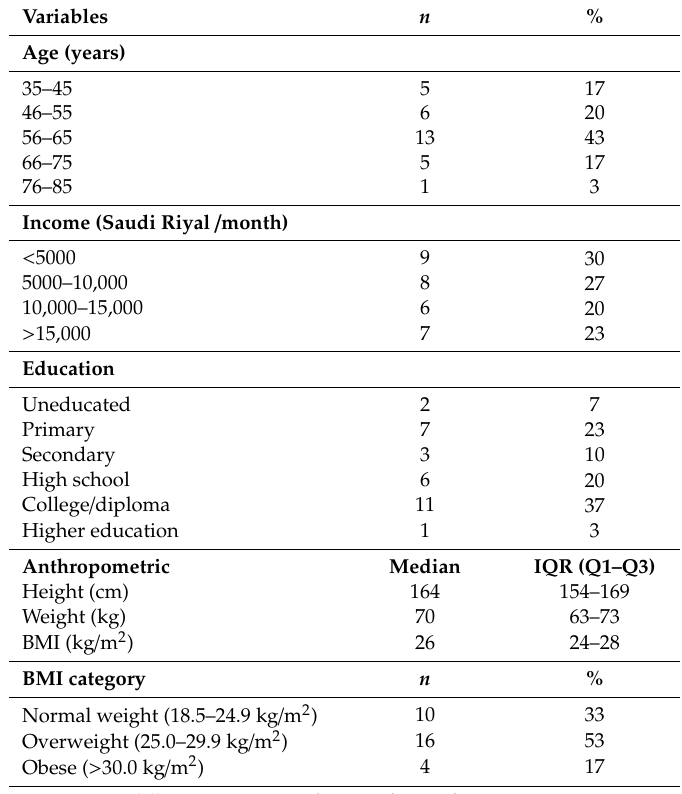
Table 1. Demographic and anthropometric data ( n = 30; male = 14, female = 16).